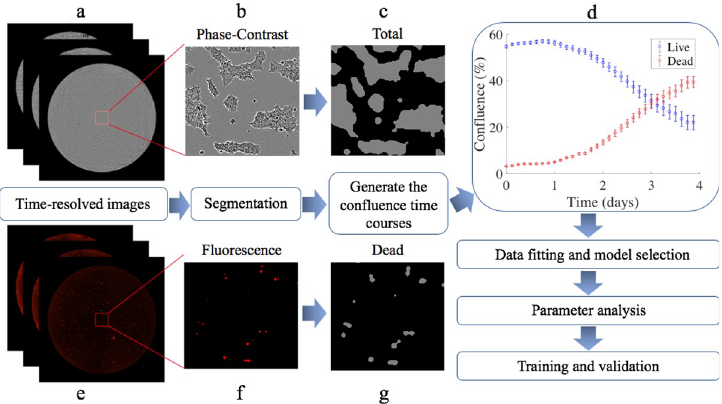
Fig 1. A flow chart indicating the data acquisition and analysis steps. Based on the phase-contrast (panels a and b) and fluorescent (panels e and f) images acquired from the time-resolved microscopy studies, we perform cell segmentation of total and dead cells (panels c and g, respectively) and generate time courses of confluence for both live and dead cells (panel d). The data are then used for selecting the most parsimonious mathematical model which estimates model parameters. Finally, the data are divided into subsets for training and validation of the predictive accuracy of the